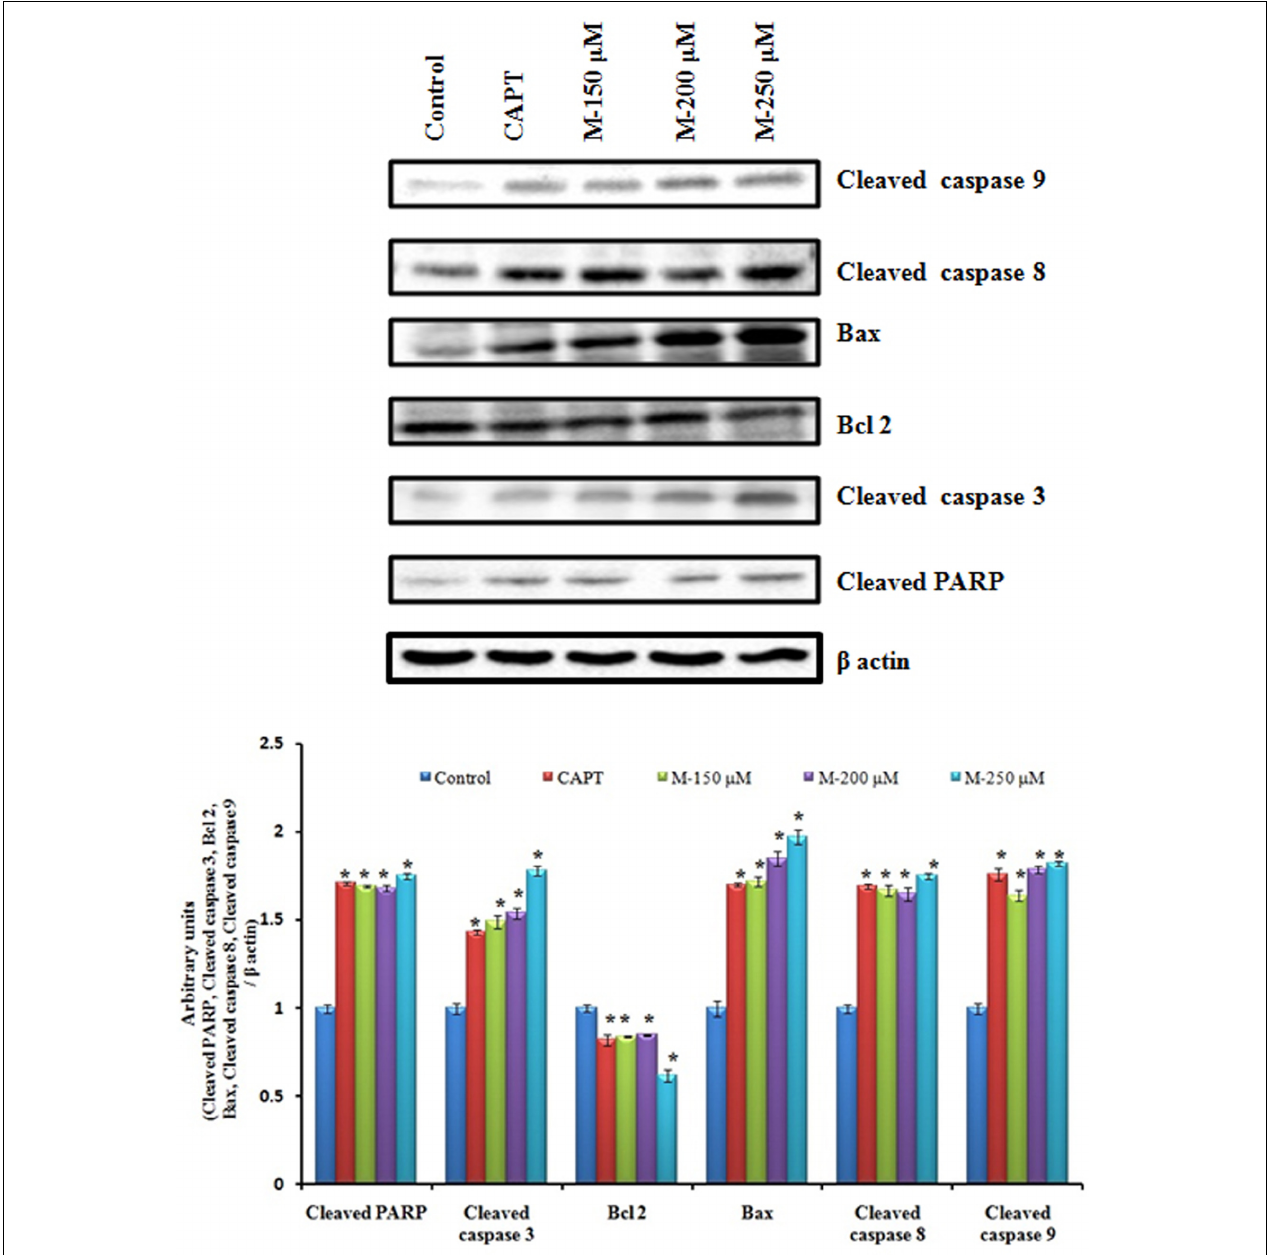
FIGURE 5 | Effects of morin on the expression of apoptosis related proteins. SW480 cells were treated with various concentrations of morin (150, 200, and 250 µ M) and camptothecin (50 µ M) for 48 h. Western blot analysis for expression of cleaved PARP, cleaved caspase 3, Bcl2, Bax, Cleaved caspase 8 and cleaved caspase 9 was carried out. CAPT: camptothecin (50 µ M), M (150, 200, and 250 µ M): Morin (150, 200, and 250 µ